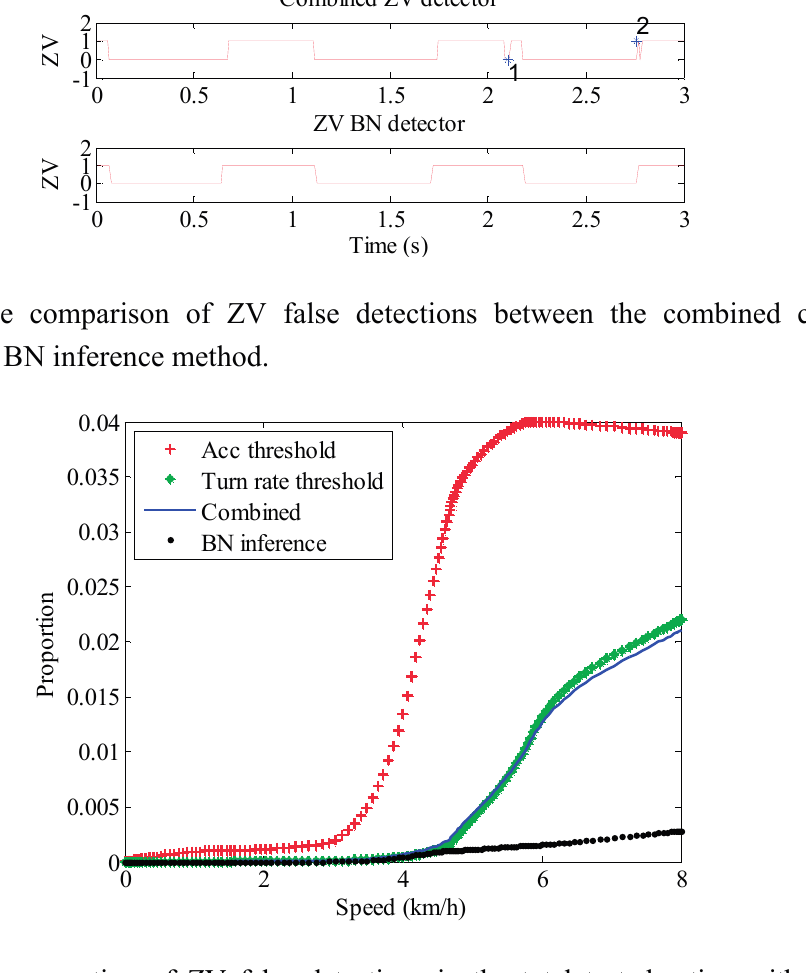
Figure 12. The proportion of ZV false detections in the total test duration with different methods at different speeds.